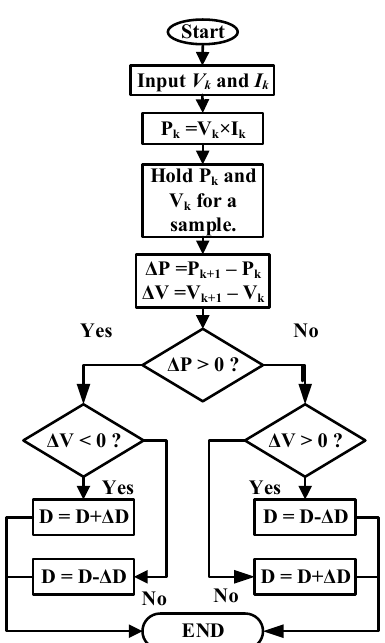
Figure 4. The perturbation and observation (P&O) algorithm utilized in this work.